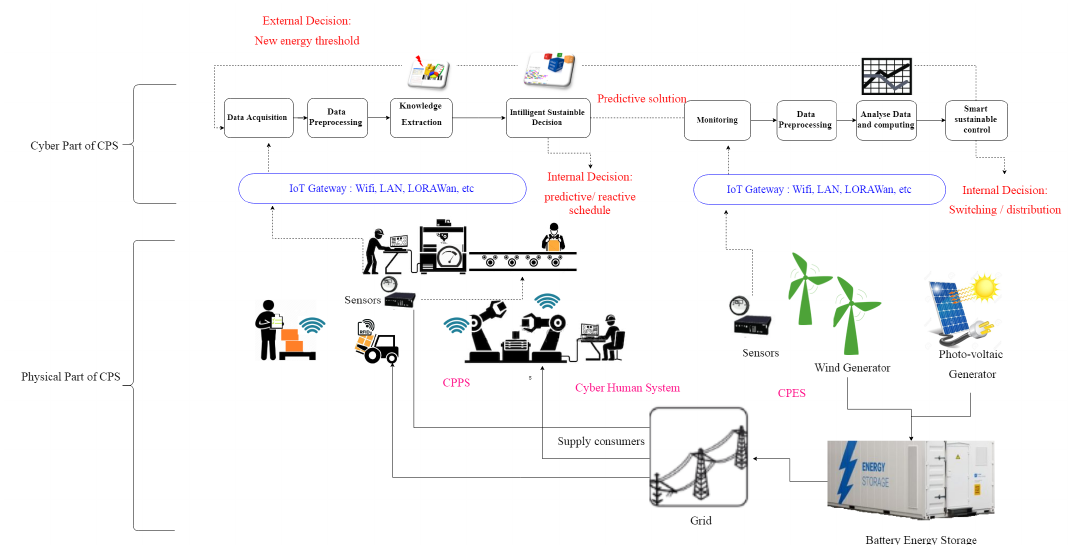
Figure 4. A detailed view on EasySched: Coordination between cyber physical production systems (CPPS) and cyber physical energy systems (CPES). Cyber physical systems